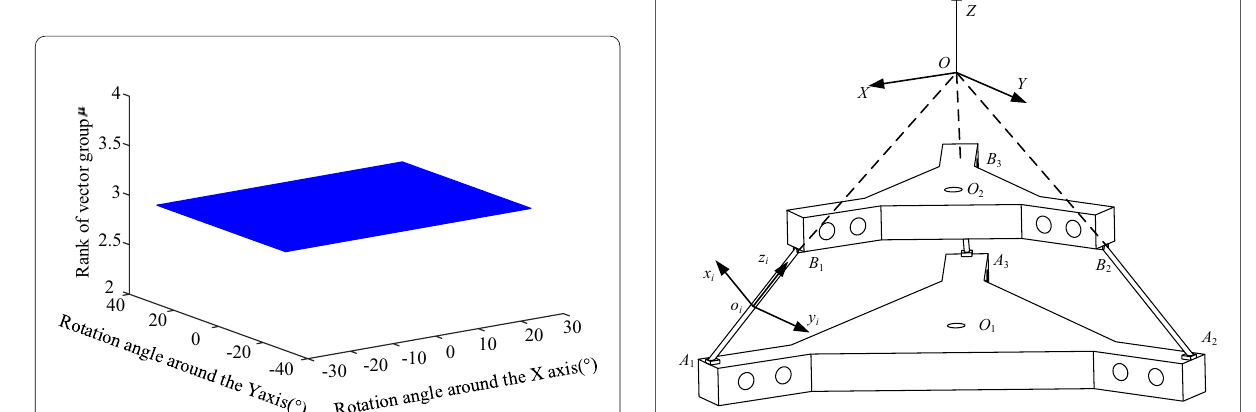
Fig. 5 Schematic diagram of 3R-DOFs constrained flexible parallel